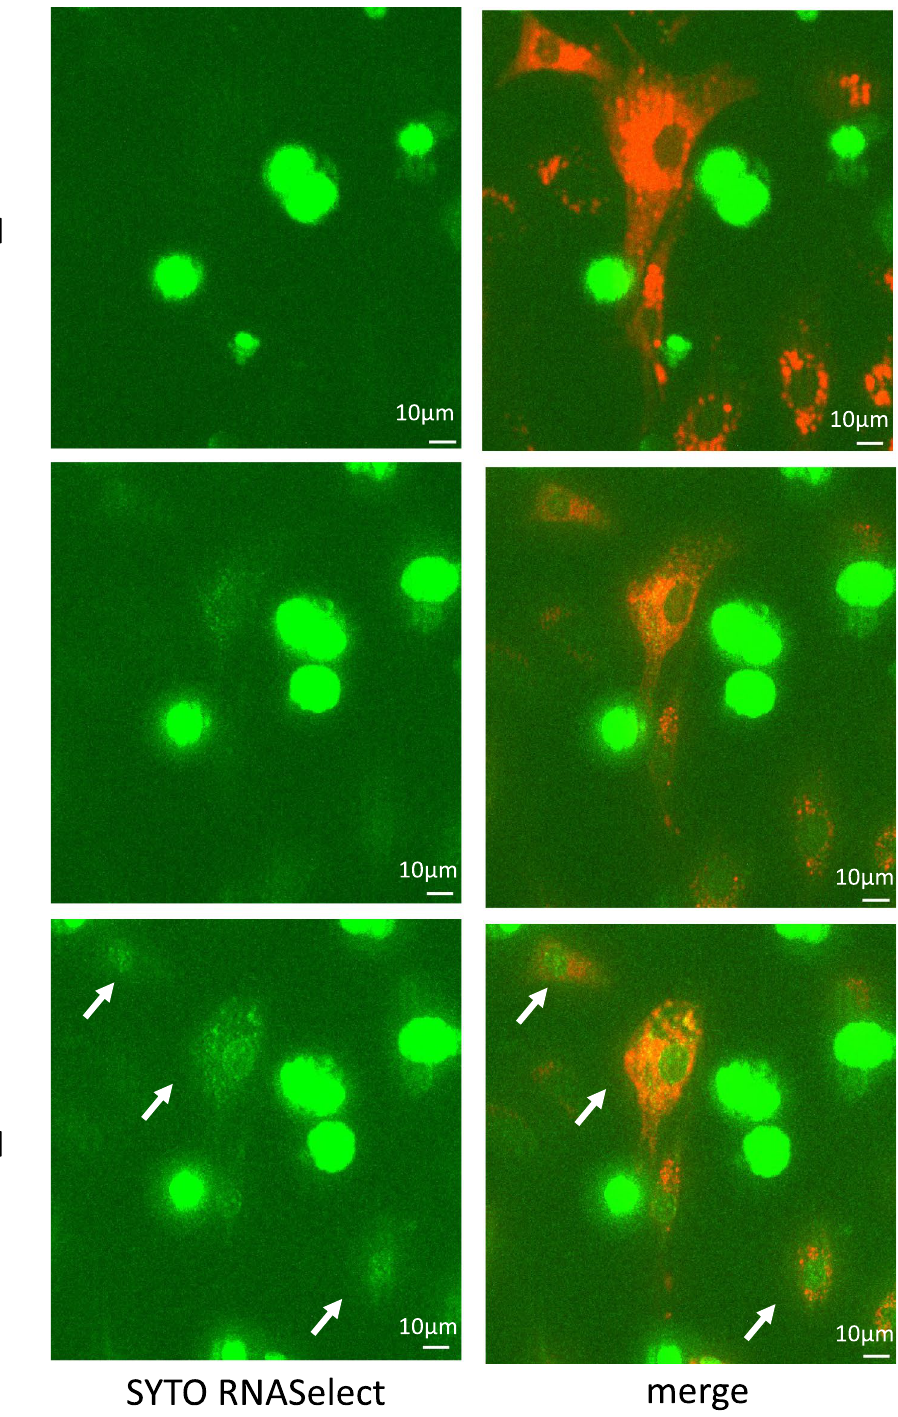
Figure 6. In vitro communication between chondrocytes and RAW264.7 cells. Green spots (indicating RNA from RAW264.7 cells) appeared gradually in chondrocytes. Red (CM-DiI): chondrocyte, green (SYTO RNASelect): RNA from RAW264.7